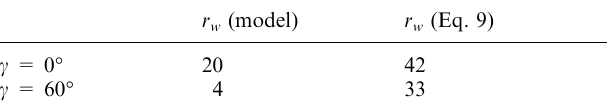
Table 7. Linear westward energy flux coe(cid:129)cients (in % of the incident energy flux). T = 180 days r (model) w